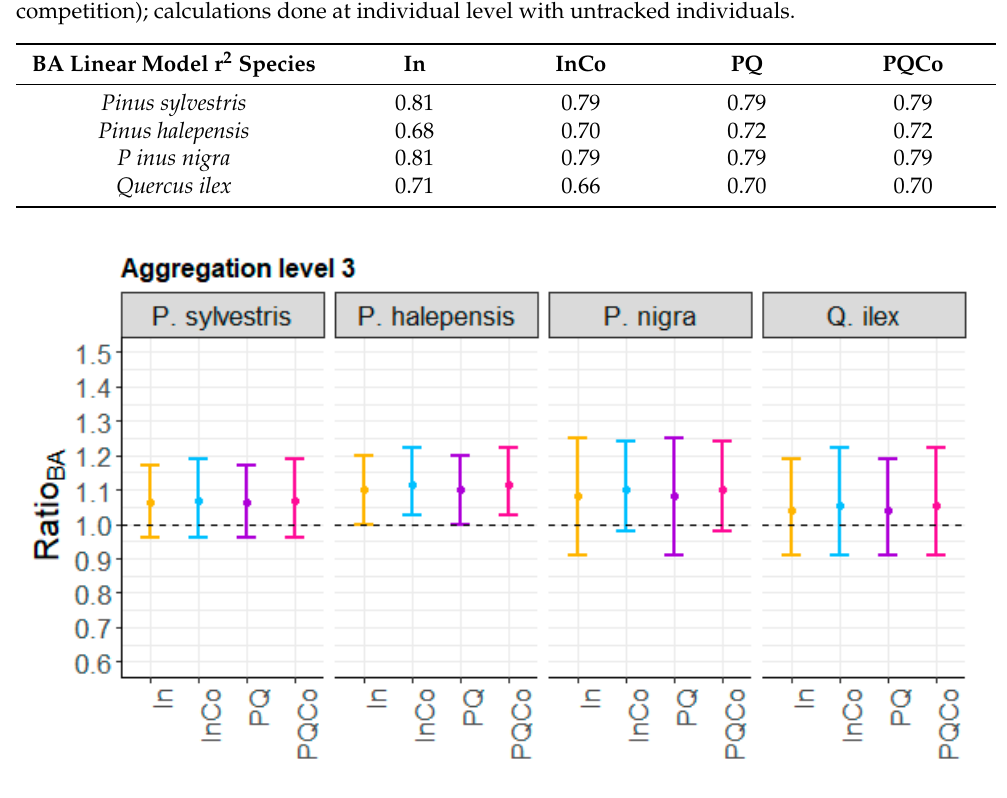
Figure A6. Each bar consists of central 95% ratio (we cut off the 2.5% levels of the smallest and largest ratios) of the total predicted basal area and the total observed basal area over the validation set for the region of Barcelona calculated over the 2000 replicas (see Section 2.3) for each species and model.